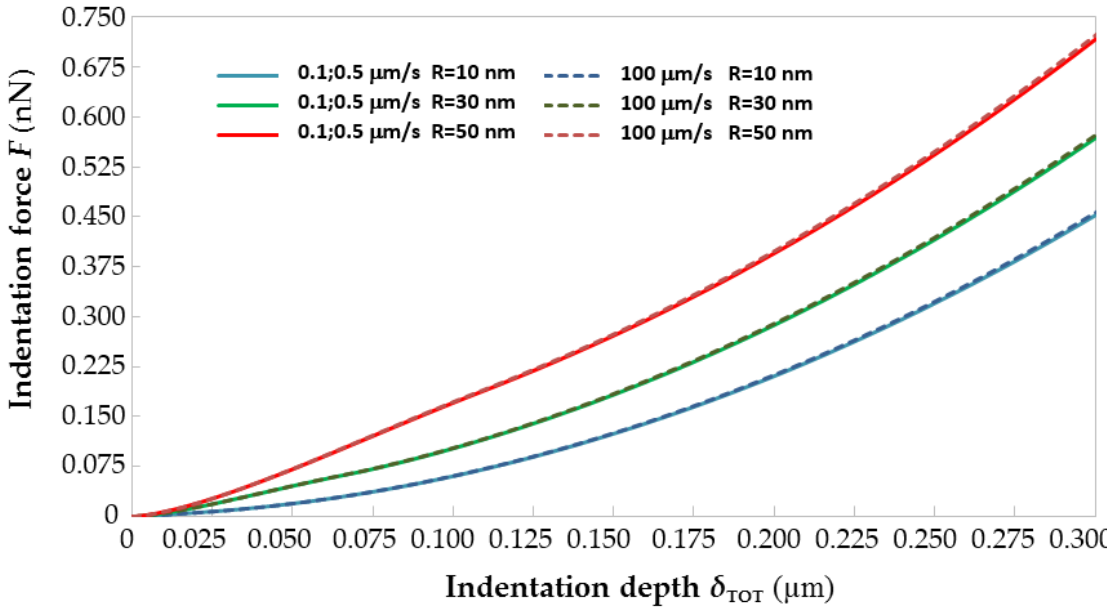
Figure 3. Effects of AFM probe geometry and indentation rate on the visco-hyperelastic response of the equine ZP.